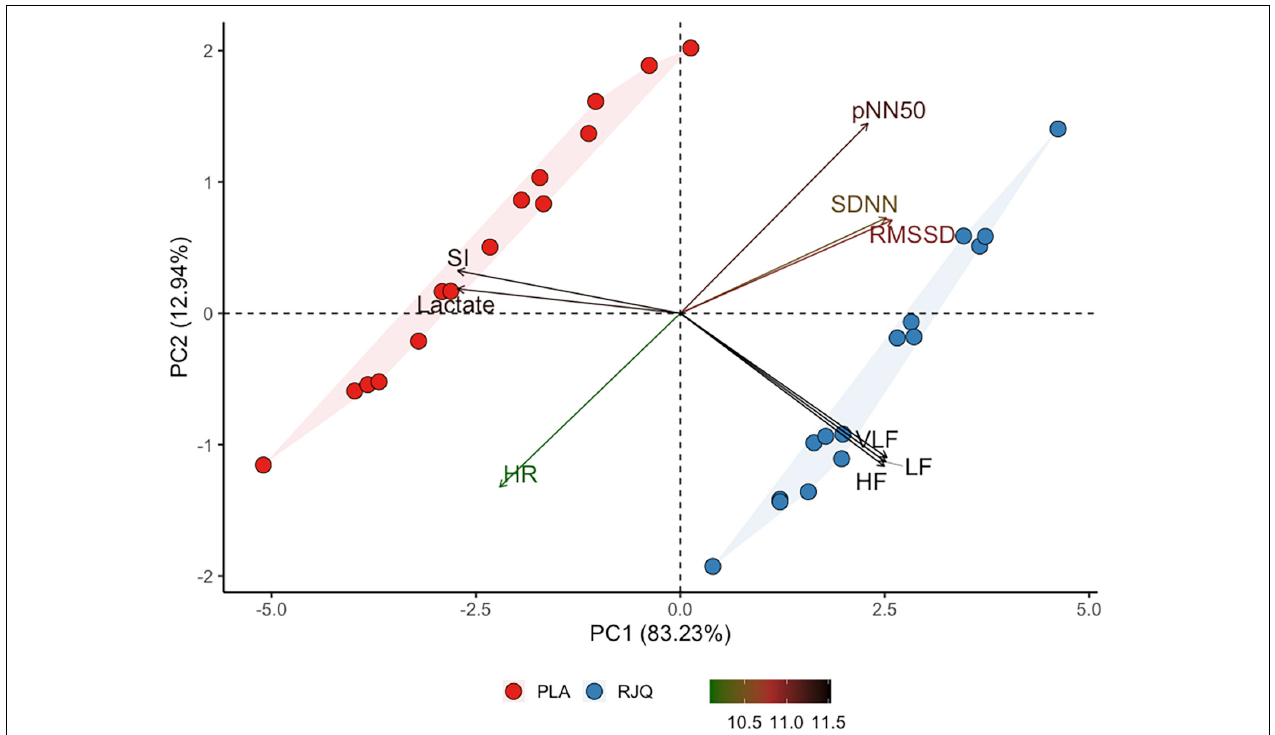
FIGURE 3 | Principal component analysis applied to the changes in RJQ-dependent variables under HIIE conditions. n = 15 per group. PC1, principal component 1; PC2, principal component 2; HR, heart rate; SDNN, standard deviation of normal-to-normal intervals; RMSSD, root mean square of successive RR intervals differences; pNN50, percentage of successive RR intervals that differ by more than 50 ms; HF, absolute power of the high-frequency band; LF, absolute power of the low-frequency band; VLF, absolute power of the very-low-frequency band; SI, stress index; RJQ, royal jelly plus coenzyme Q10; PLA,